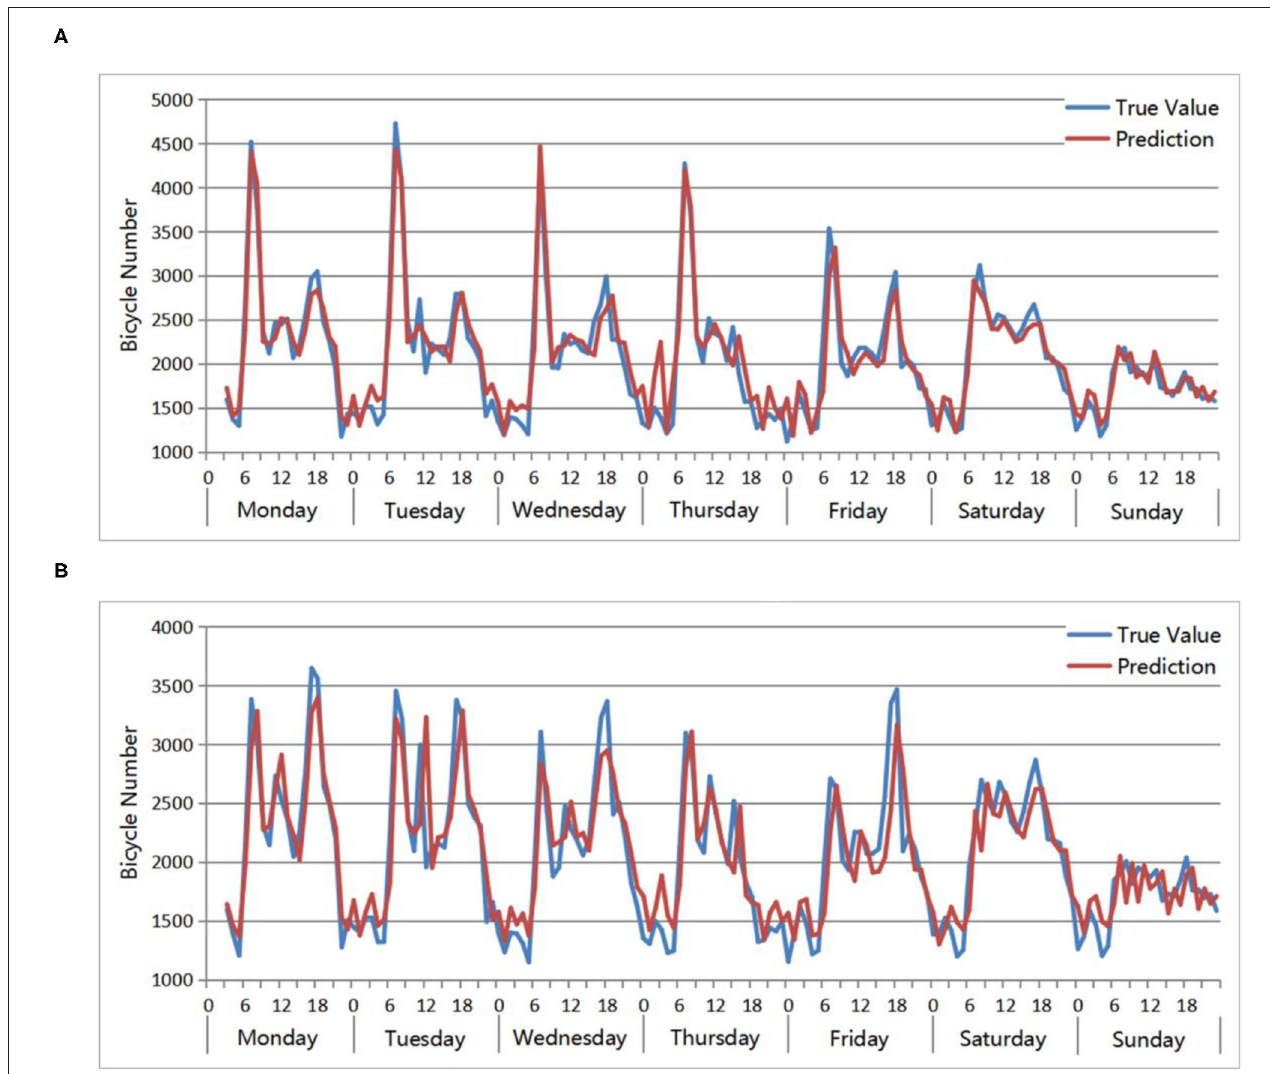
FIGURE 9 | Accuracy evaluation: true value and prediction of QPSO-LSTM in residential areas. (A) Origin points number. (B) Destination points